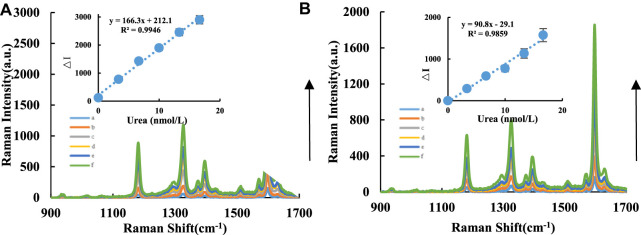
SERS spectra of CD-H2O2-TMB-Apt-AgNP analysis system. A/B compared the catalytic effects between CDFe and CDFeN in the urea analysis system. (A): CDFe-H2O2-TMB-Tris-HCl-Apt-Urea-AgNPs system, a: 0.04 μg/ml CDFe+5.0 μmol/L H2O2+ 0.03 mmol/L TMB+0.51 mmol/L PH = 4.07 Tris-HCl+10 nmol/L Apt+ Urea+0.08 mmol/L AgNPs; b: a+3.33 nmol/L Urea; c: a+6.66 nmol/L Urea; d: a+9.99 nmol/L Urea; e: a+13.32 nmol/L Urea; f: a+16.65 nmol/L Urea. (B): CDFeN-H2O2-TMB-Tris-HCl-Apt-Urea-AgNPs system, a: 0.04 μg/ml CDFeN+ 5.0 μmol/L H2O2+ 0.03 mmol/L TMB+ 0.51 mmol/L PH = 4.07 Tris-HCl+10 nmol/L Apt+ Urea+0.08 mmol/L AgNPs; b: a+3.33 nmol/L Urea; c: a+6.66 nmol/L Urea; d: a+9.99 nmol/L Urea; e: a+13.32 nmol/L Urea; f: a+16.65 nmol/L Urea.